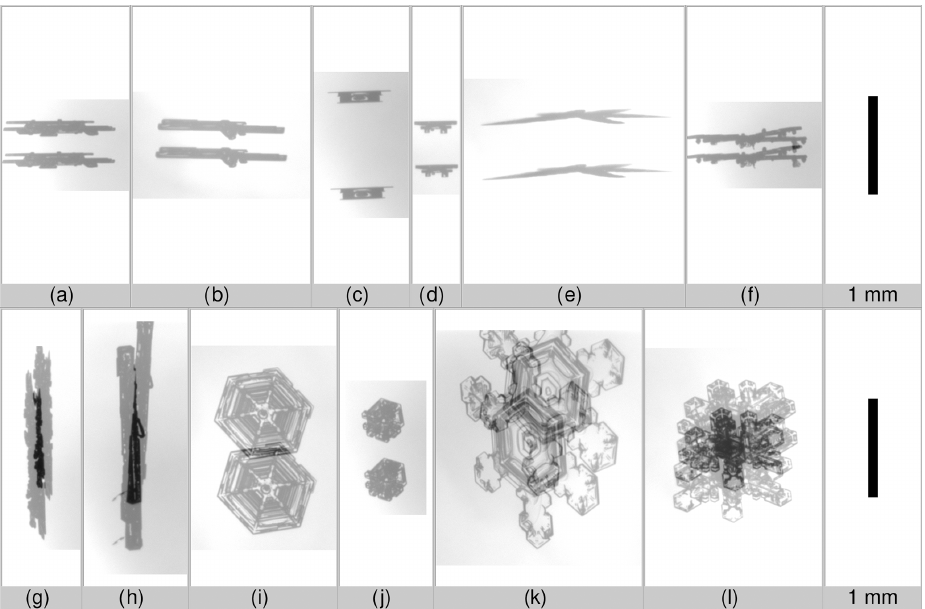
Figure 10. Panels (a) – (f) show six examples using side views of different particles with horizontal orientation, and panels (g) – (l) show six examples using side views of different particles with vertical orientation. These particles have an elongated shape (shape group (1) Needles ) and planar shape (shape groups (5) Plates and (6) Stellar ). Two examples of each shape group are displayed for both orientations. The same scaling is applied to all images; a 1mm scale bar is shown for reference.